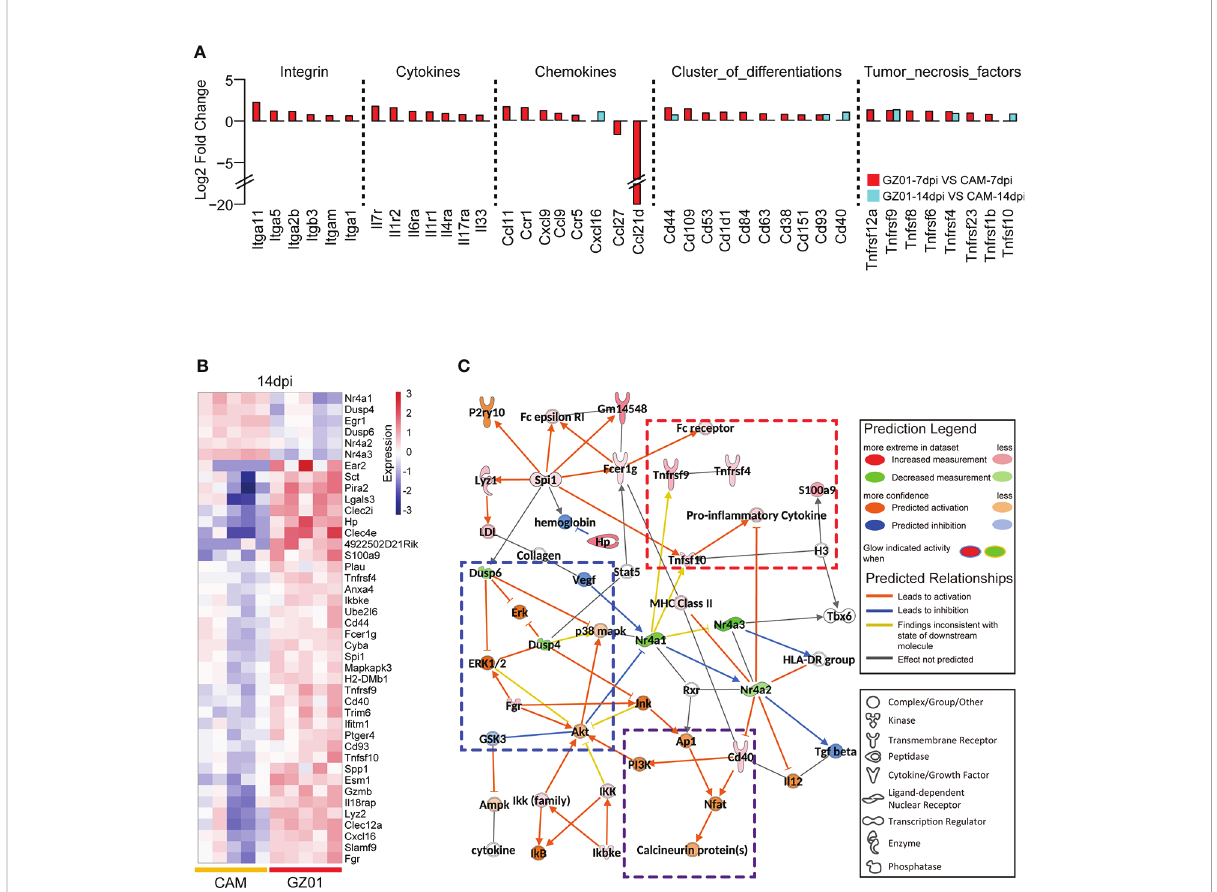
FIGURE 4 Differential expression pro fi les of immune molecules between two strains infected mice. (A) , Fold change of differentially expressed cytokines between mice infected with GZ01 and CAM at 7 dpi and 14 dpi. (B) , Heatmap of differentially expressed immune genes between CAM and GZ01 at 14 dpi. (C) , Regulatory networks of differentially expressed immune genes and predictive regulatory genes at 14